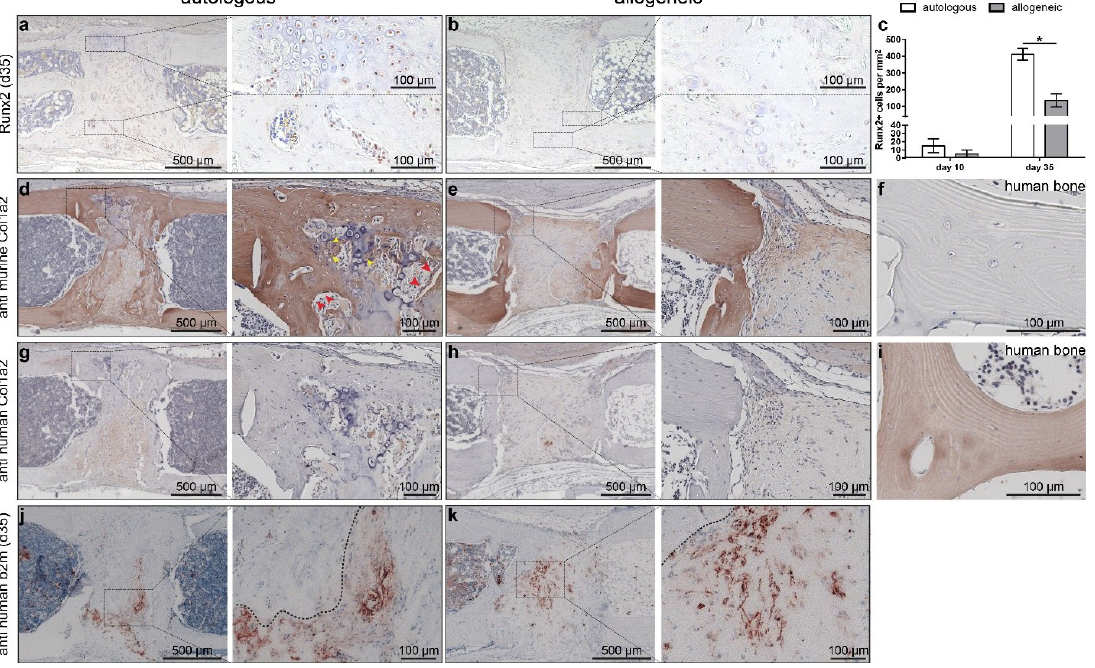
Figure 5. Analysis of osteogenesis by autologous and allogeneic human mesenchymal stem cells (hMSC) on day 35. ( a – c ) Staining of Runx2 on day 35 ( a , b ) and quantification ( c ) in mice with ( a ) autologous hMSC treatment and ( b ) allogeneic hMSC treatment. ( d – f ) Staining for murine collagen type 1α2 in ( d ) mice with autologous hMSC treatment, ( e ) mice with allogeneic hMSC treatment, and ( f ) human control tissue. ( g – i ) Staining for human Col1α2 in mice with ( g ) autologous hMSC treatment, ( h ) allogeneic hMSC treatment, and ( i ) human bone. ( j , k ) staining for human β2-microglobulin (b2m). Dashed boxes indicate areas displayed in higher magnification. The data are presented as the mean ± SD, * p ≤ 0.05, n = autologous n = 2; allogeneic n = 3. Red arrowheads in ( d ) indicate bone lining cells positive for murine Col1α2; yellow arrowheads indicate cells within hypertrophic cartilage positive for murine Col1α2.